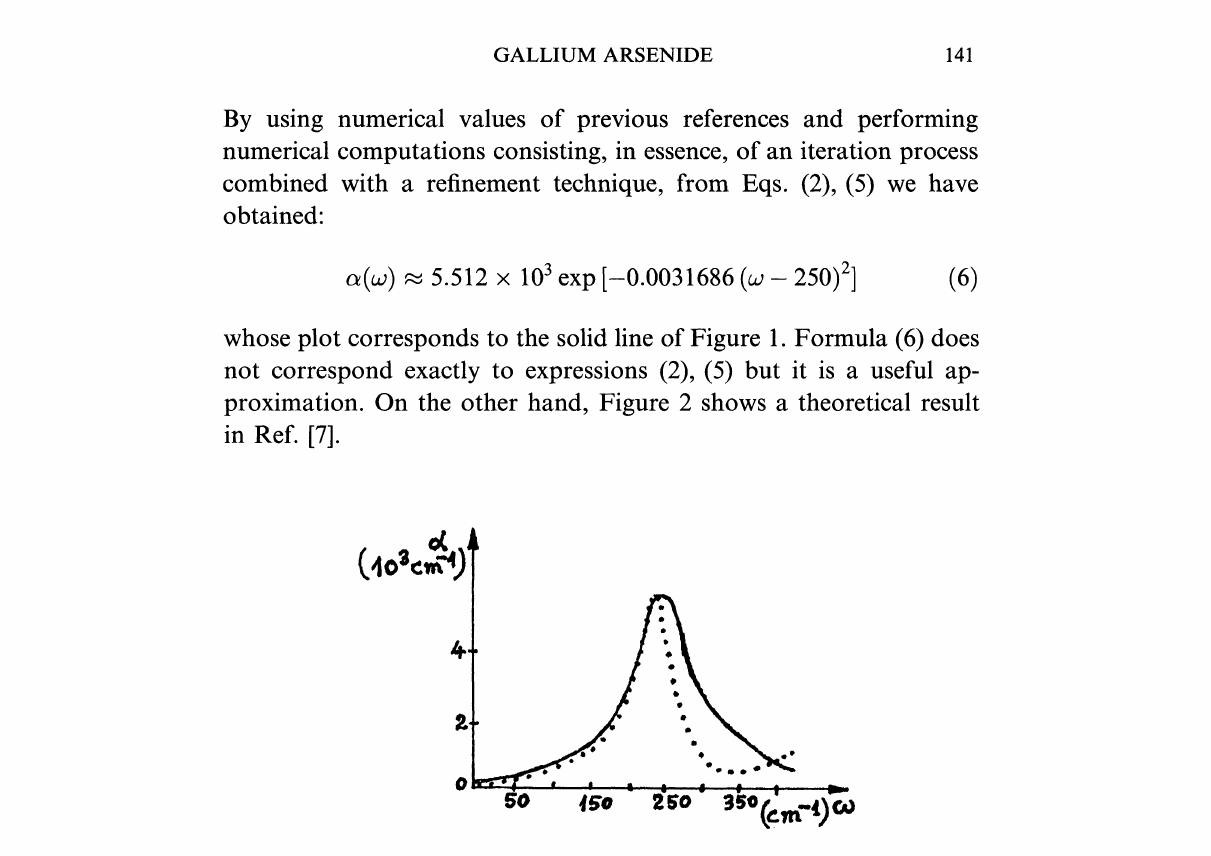
FIGURE Plots of c (co) for a-GaAs in the far infrared range; the dotted line is experimental (after Ref. [6]) and the solid line is theoretical.